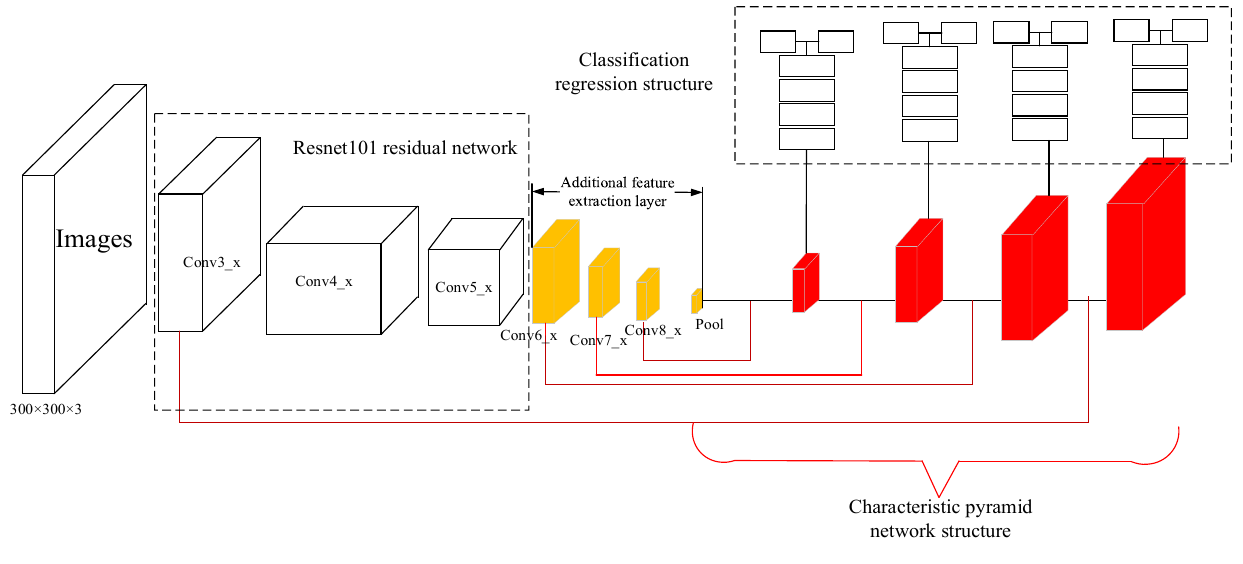
Figure 3. Improved SSD structure.